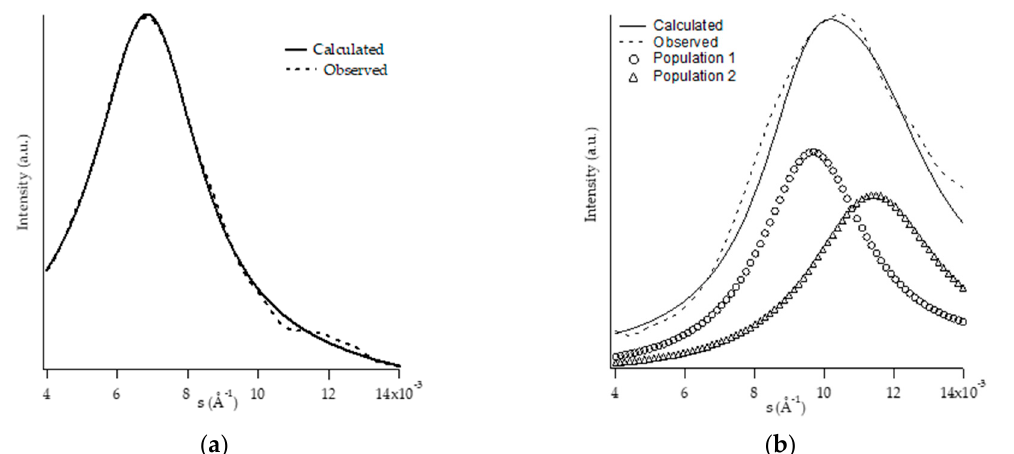
Figure 8. SAXS pattern (dotted line) and trace calculated by fitting procedure (solid line) of PB1 ( a ) and PB2.4 ( b ).